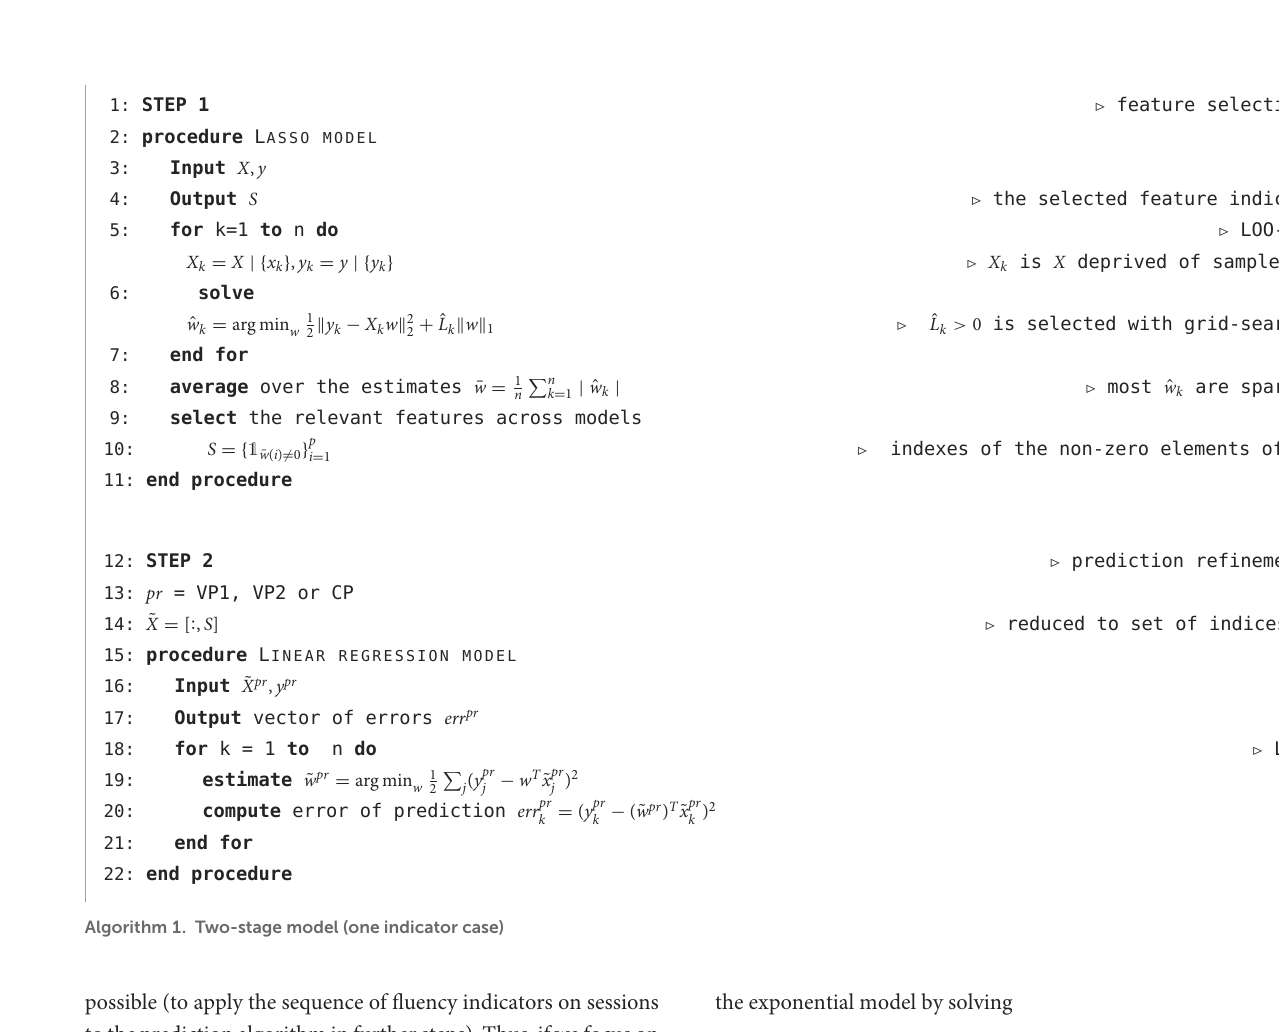
possible (to apply the sequence of fluency indicators on